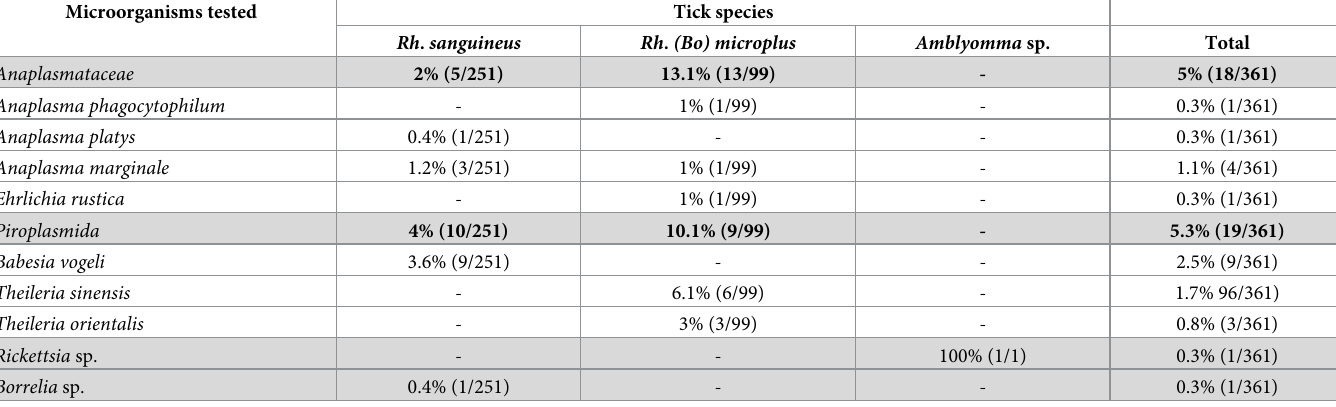
Table 3. Microorganisms detected using molecular biology tools in ticks collected in Vietnam. Microorganisms